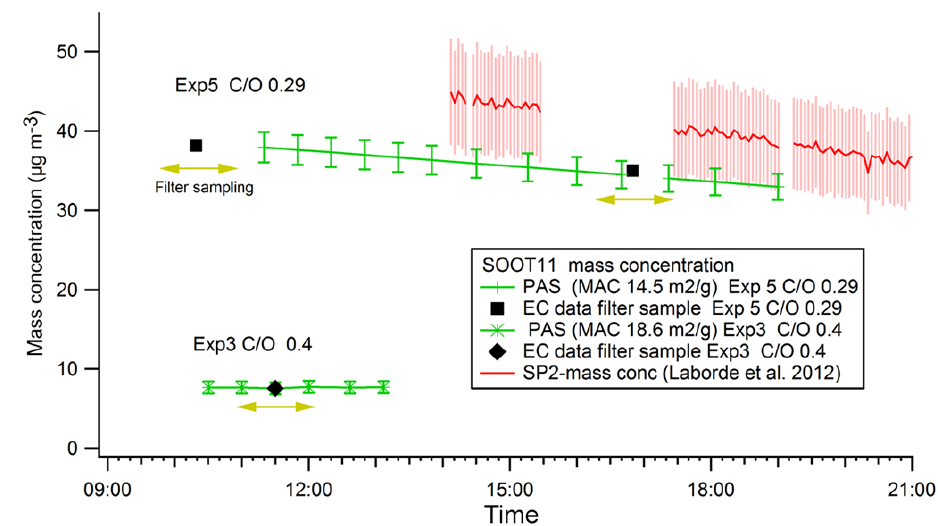
Figure 5. Comparison of mass concentrations determined for two experiments in the SOOT11 campaign by SP-2, filter sampling, and 1- λ -PAS at 532nm